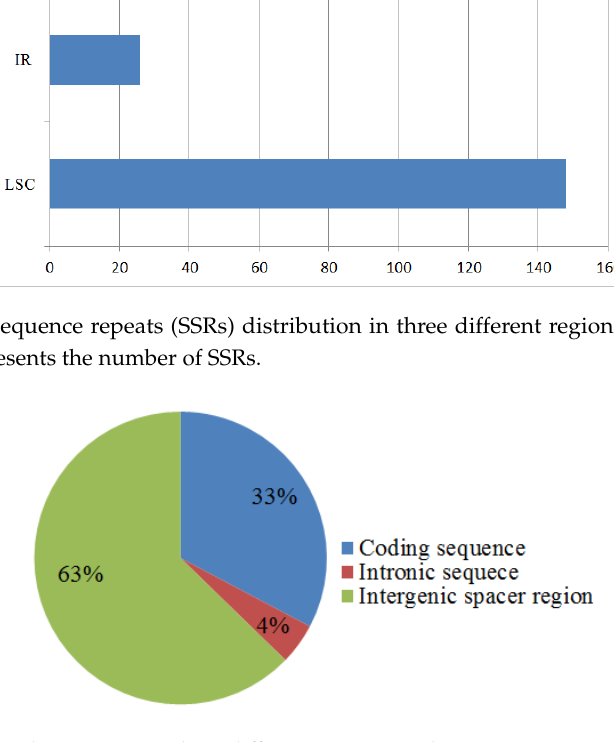
Figure 6. Repeat distribution among three different regions: coding sequences, intronic sequences, and intergenic spacer regions.